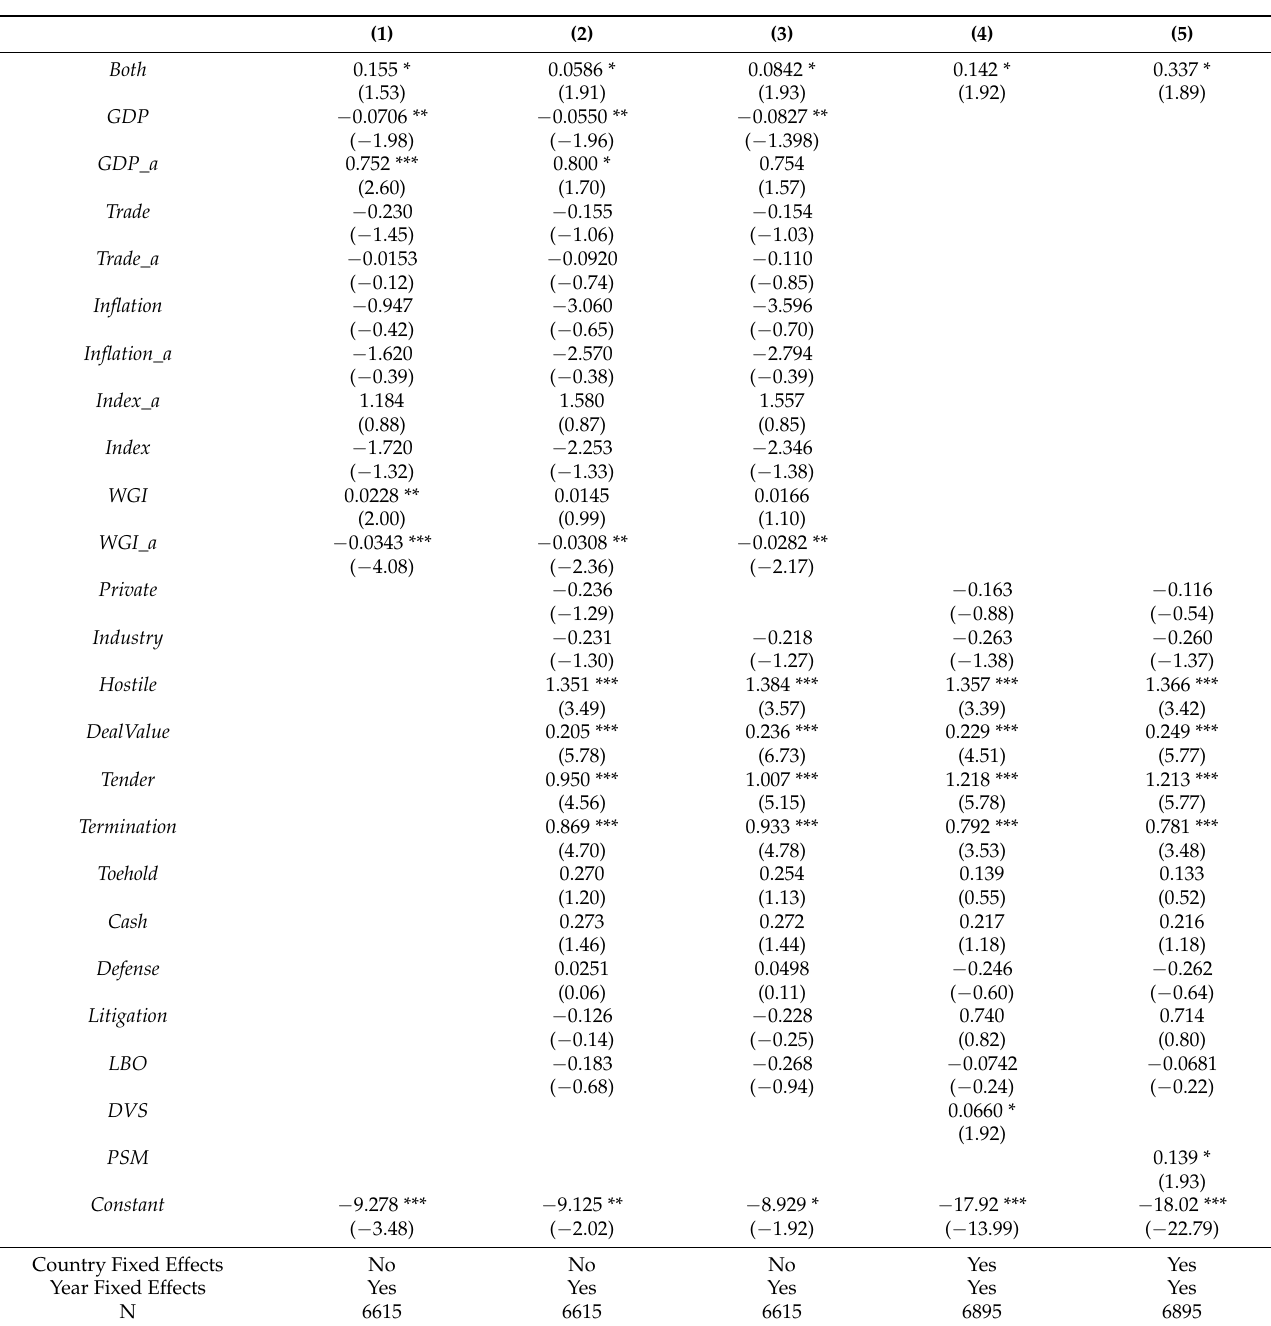
Table A4. This table presents the results of probit regressions run on the ‘same region’ subsample. The subsample includes only cross-border deals that took place where the acquirer and target countries are domiciled within in the same region. The regions used were: North America, Asia Pacific, Europe, Latin America, Middle East and Africa. The dependent variable is Compete and the main independent variable of interest is Both which is an indicator variable that equals 1 if social media is popular in both the acquirer and target countries. Models 1, 2 and 3 control for macroeconomic variables of both the acquirer and target nations. Models 2 to 5 control for deal-level variables specified above. Standard errors are clustered by